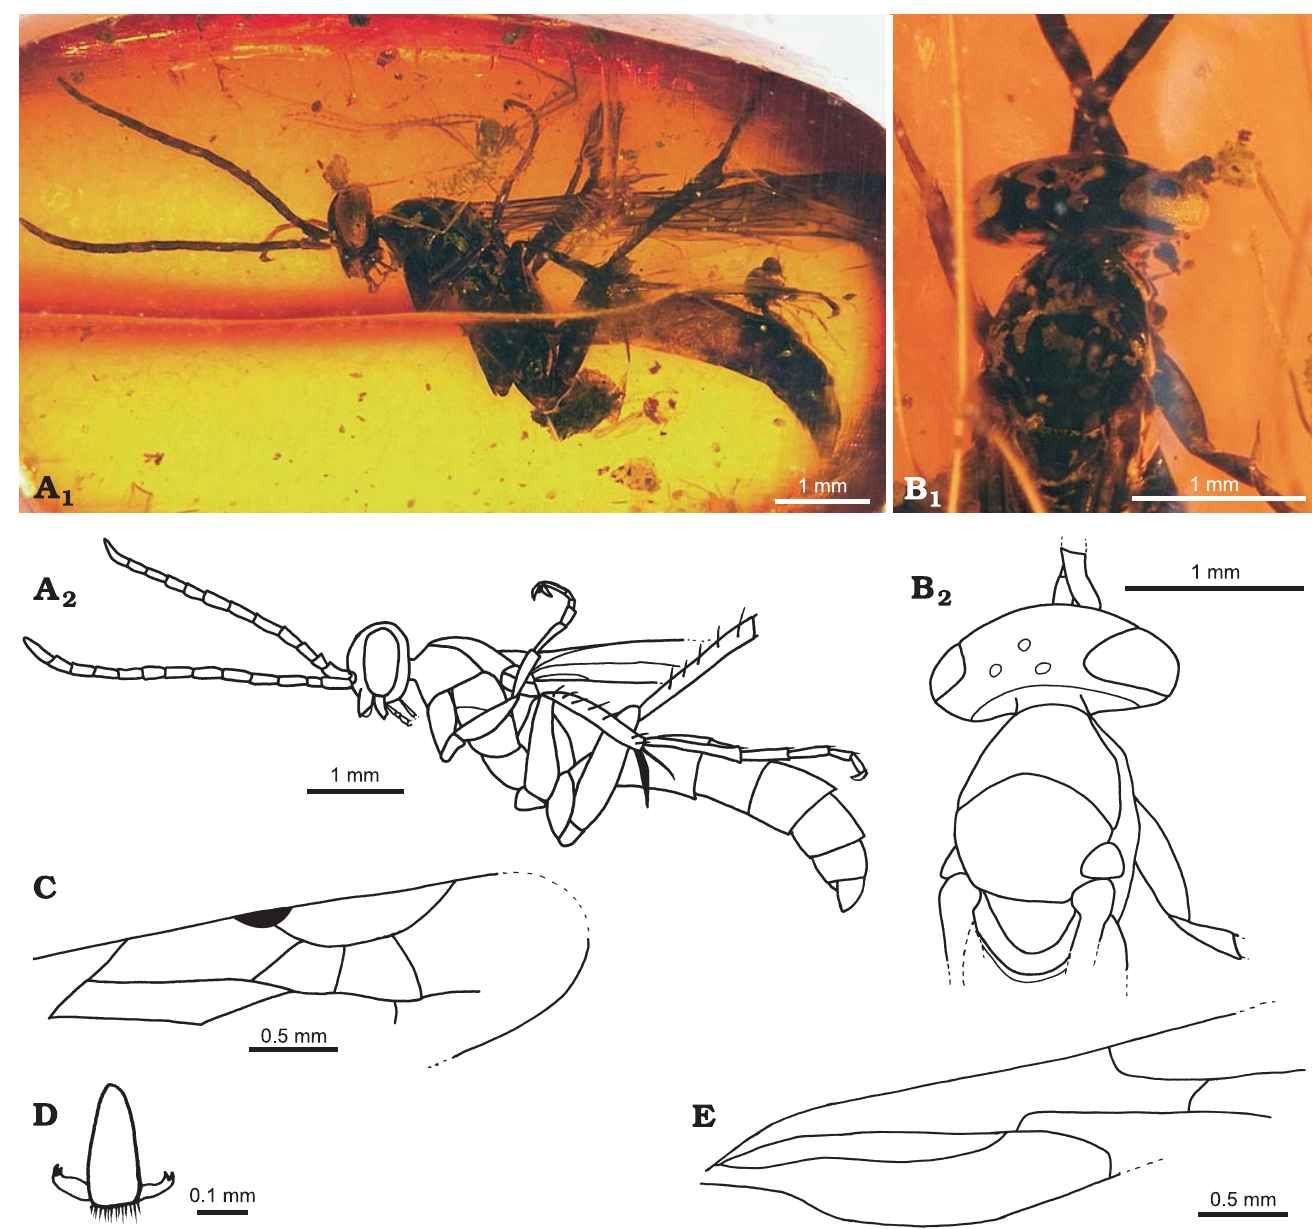
Fig. 1. Spider wasp Anoplius planeta Rodriguez and Pitts sp. nov., holotype, OSAC Hy-10-45, male specimen, from Early Miocene Dominican amber, Cordillera Septentrional, between Puerto Plata and Santiago, Dominican Republic. A . Habitus in lateral view. B . Mesosoma in dorsal view. C . Forewing. D . Pulvillus. E . Hindwing. Photographs (A 1 , B 1 ), camera lucida illustrations (A 2 , B 2 ,